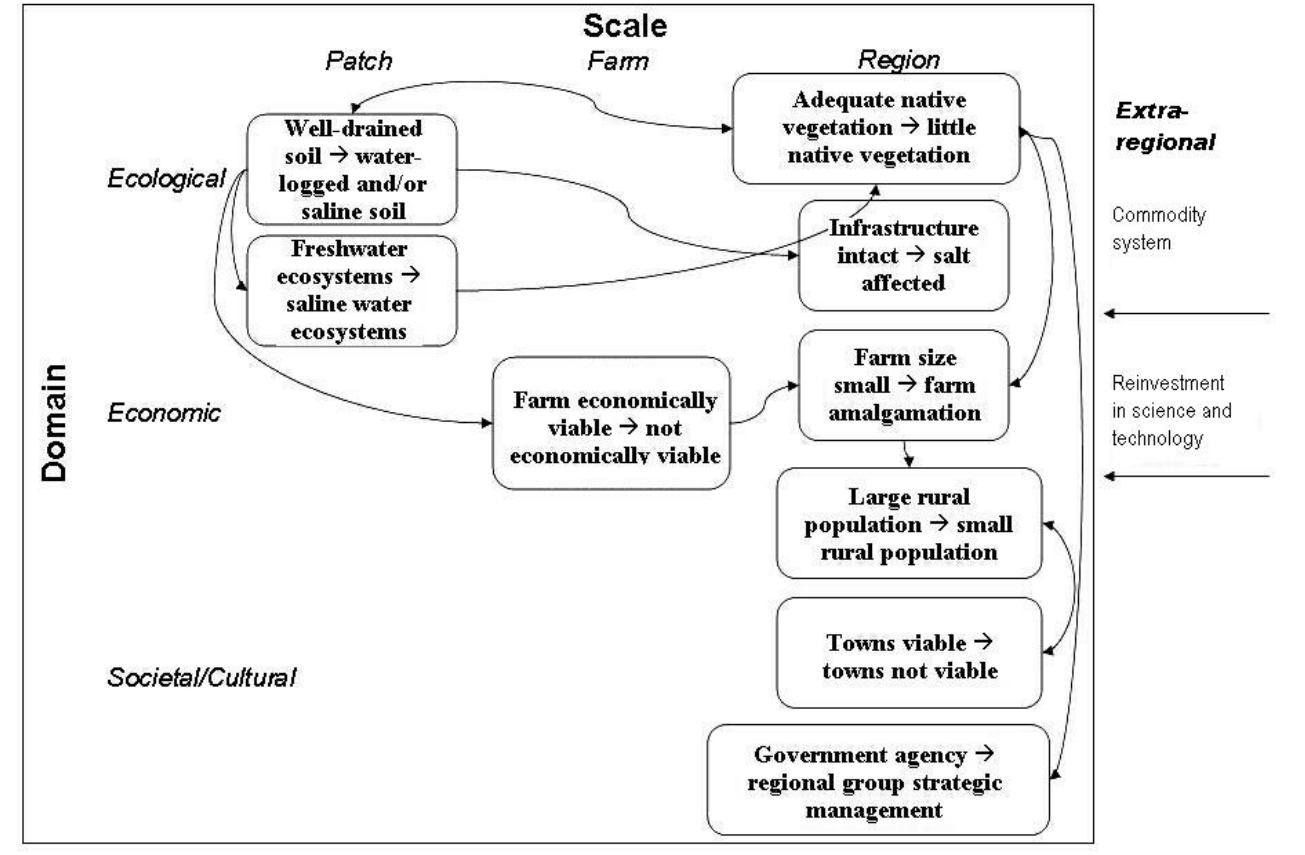
Fig. 7 . The key threshold interactions in the western Australian wheatbelt in the three domains and at three scales. Note that there are also forces operating at the global scale, notably the availability of new technologies, climate change, and the global demand for cereal